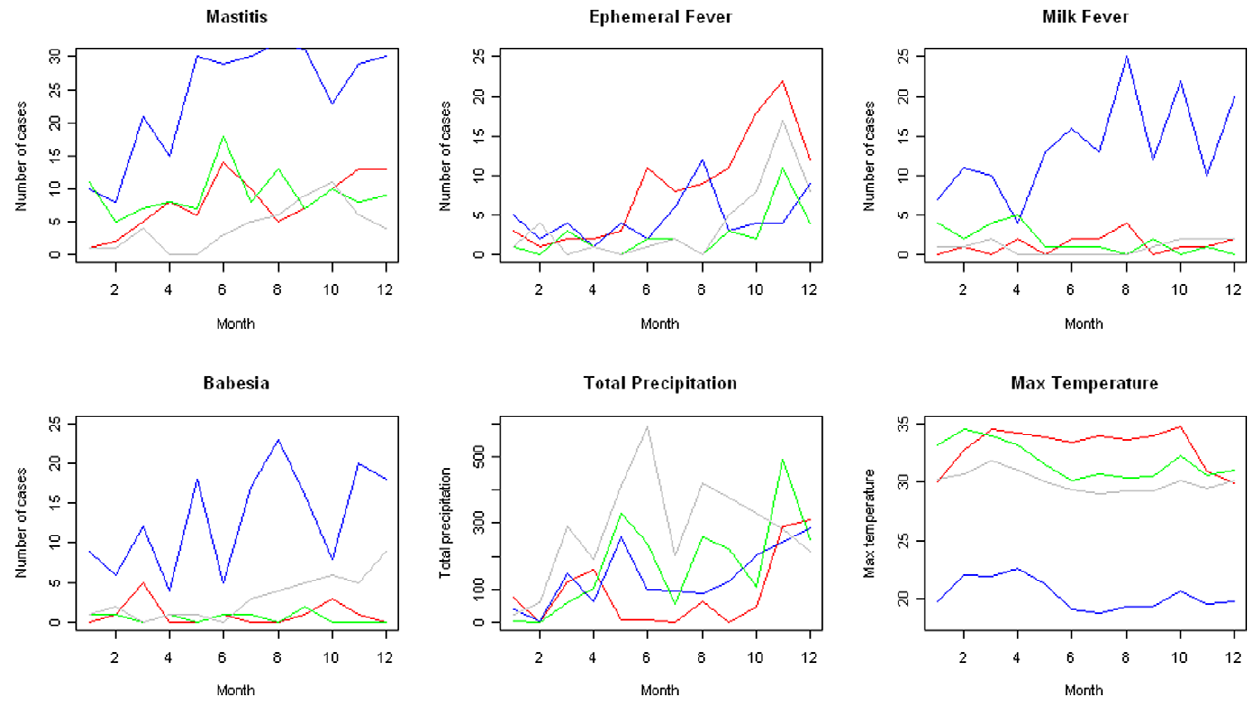
Figure 6. Monthly total cases for commonly reported diagnoses in each of the four districts. Anauradhapura (red), Nuwara Eliya (blue), Matara (green), and Ratnapura (grey). Monthly averages for district-wide total precipitation and maximum temperature.